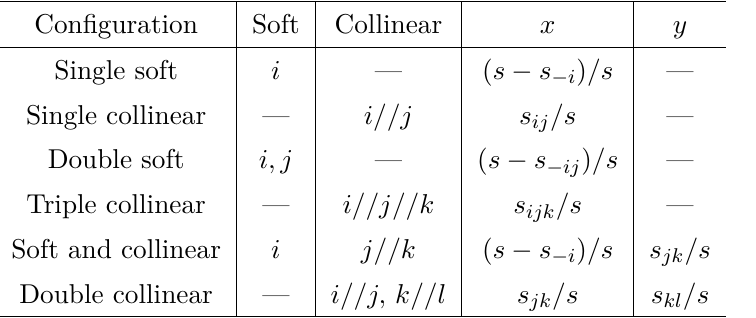
Table 3 . Variables x and y used to test the IR limits. The first two lines refer to single unresolved limits, the remaining ones to double unresolved limits.